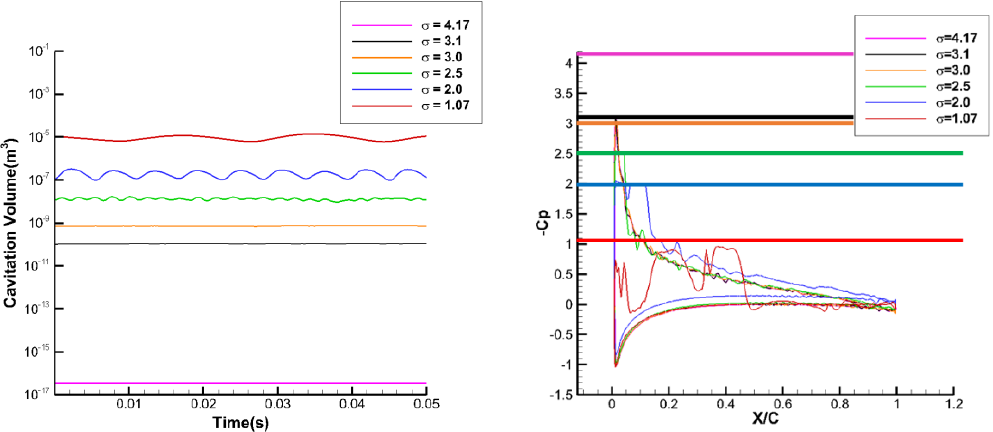
Figure 15. Cavitation-volume/time graph according to cavitation number ( left ) and Cp curve according to cavitation number at an instantaneous time ( right ).